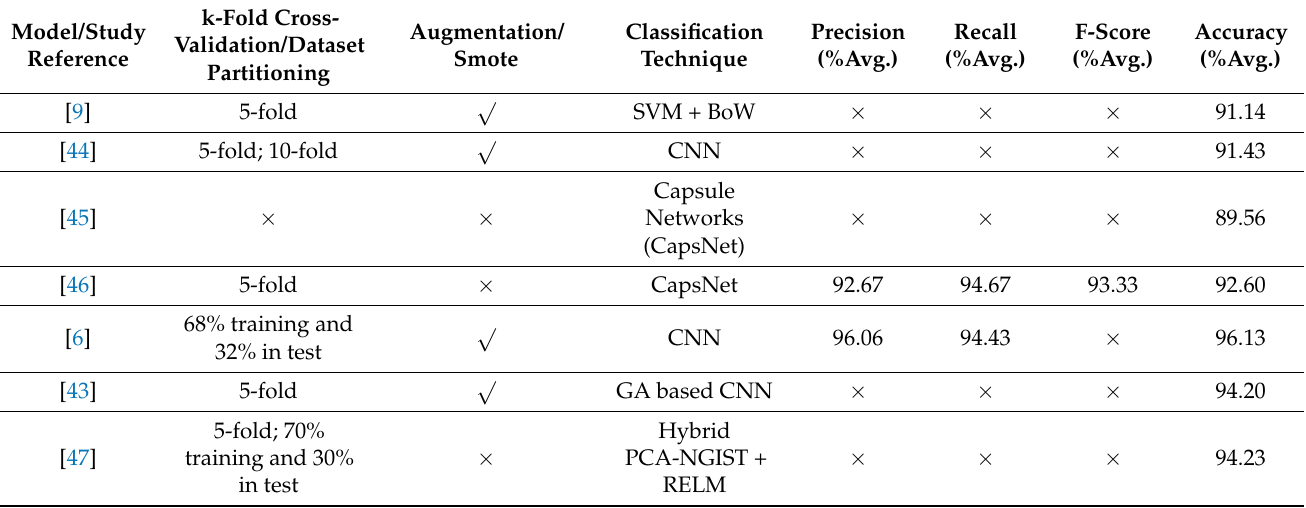
Table 12. Comparison with other studies for brain tumor categorization using CE-MRI